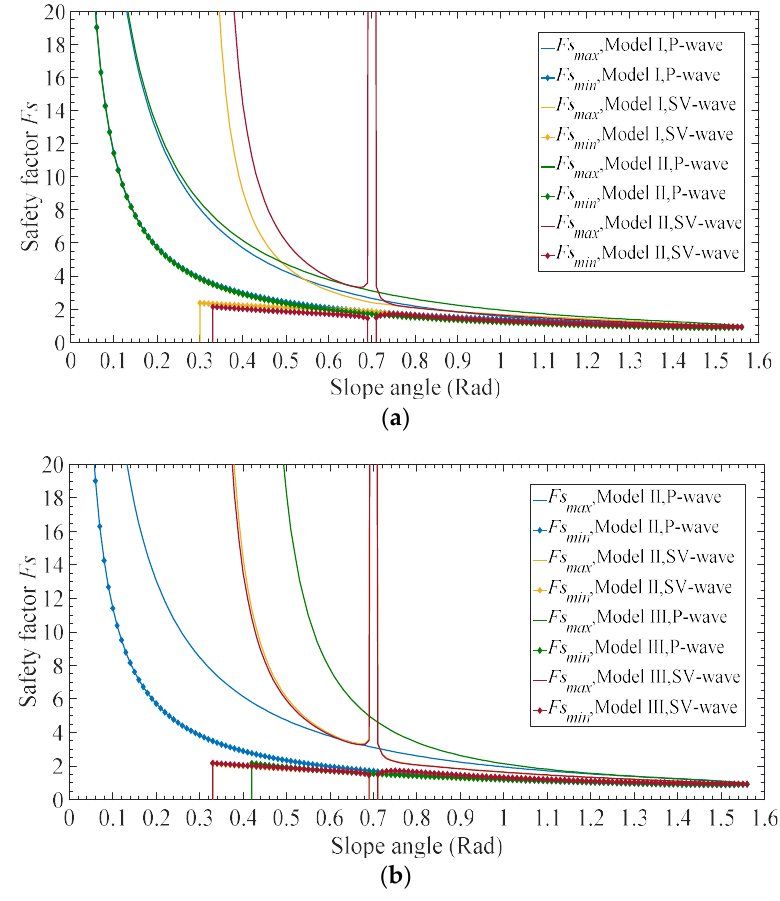
Figure 3. Instantaneous safety factor vs. slope angle, and the incident direction keeps constant: ( a ) comparison between models I and II; ( b ) comparison between models II and III.